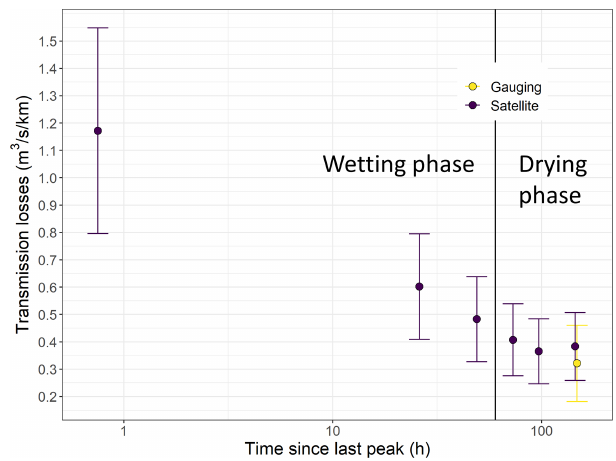
Figure 7. Selwyn River transmission losses estimated using differ- ential gauging (“Gauging”, yellow) and river drying front locations identified on satellite imagery (“Satellite”, purple) as a function of the time since the last peak (log10 scale) during the September 2020 selected event.